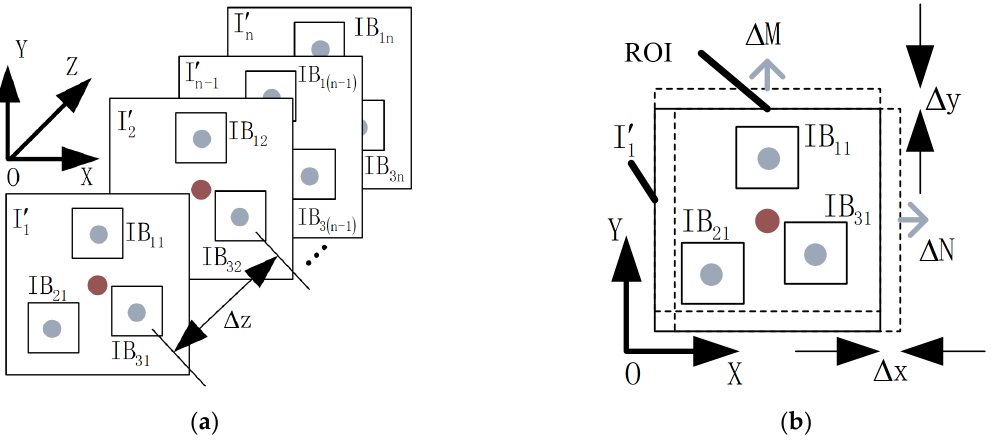
Figure 5. Reference curve data acquisition. ( a ) Z-axis; ( b ) X-axis and Y-axis. Equation (4) can calculate the autocorrelation coefficients of the 64 × 64 image blocks of each frame of the B-scan sequence and the corresponding image blocks of the first B-scan frame. Assuming that n is the number of B-scans, we can obtain n-1 discrete data points. Through curve fitting these discrete points, the correlation curve of Z-axis direction is obtained. In the same way, the correlation curve of the X-axis and the Y-axis can be obtained, as shown in Figure 5. The range of single movement distance ∆ x and ∆ y of ROI along the X-axis and Y-axis is shown in Equation